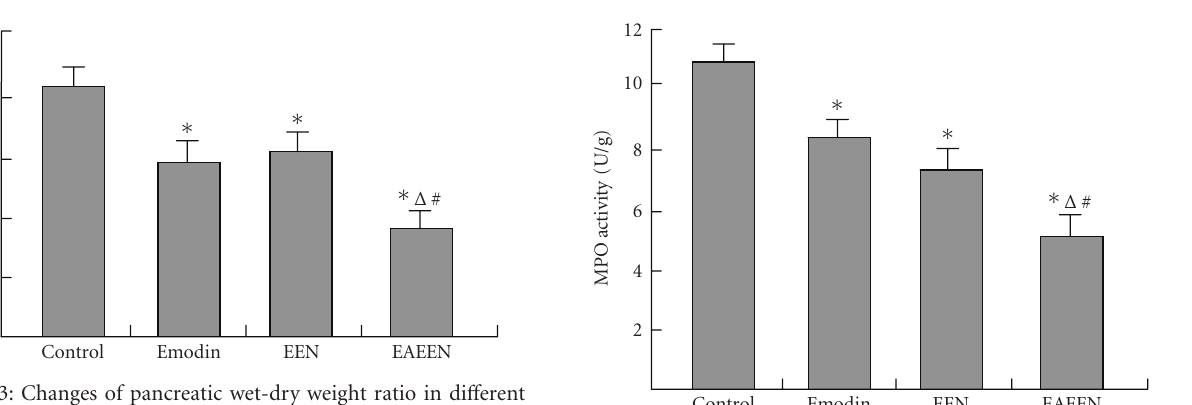
Figure 3: Changes of pancreatic wet-dry weight ratio in di ff erent groups. ∗ P < . 05 versus control group; Δ P < . 05, EAEEN group versus Emodin group; # P < . 05, EAEEN group versus EEN group. Figure 4: Changes of MPO activity of pancreas in di ff erent groups. ∗ P < . 05 versus control group; Δ P < . 05, EAEEN group versus Emodin group; # P < . 05, EAEEN group versus EEN group. EEN: early enteral nutrition. EAEEN: emodin-assisted early enteral nu- trition. MPO: